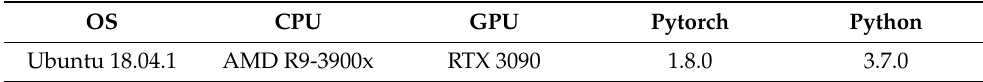
Table 1. Running and testing